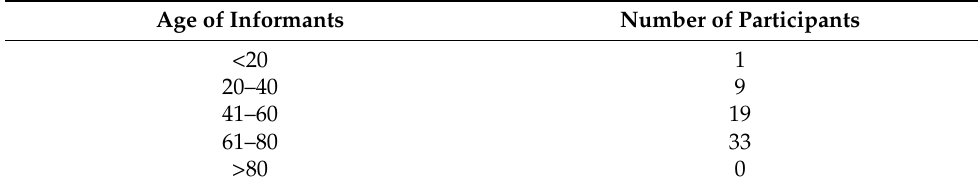
Table 1. Demographic features of